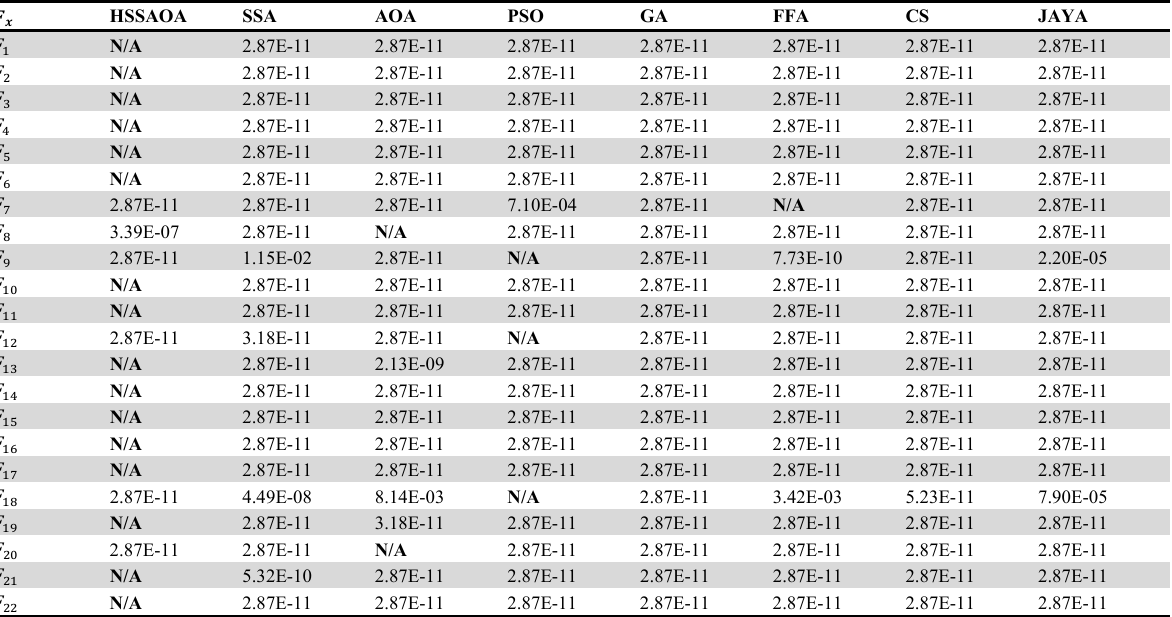
According to Group 2, wilcoxon rank sum test 𝑝 values (N/A = not applicable)